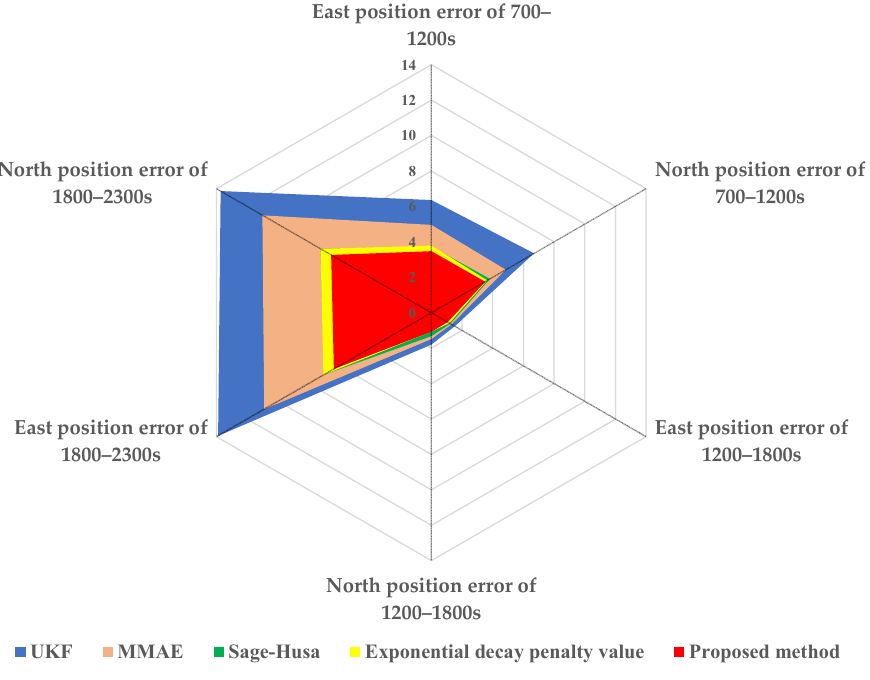
Figure 7. Radar map for MSE of position error of four methods.